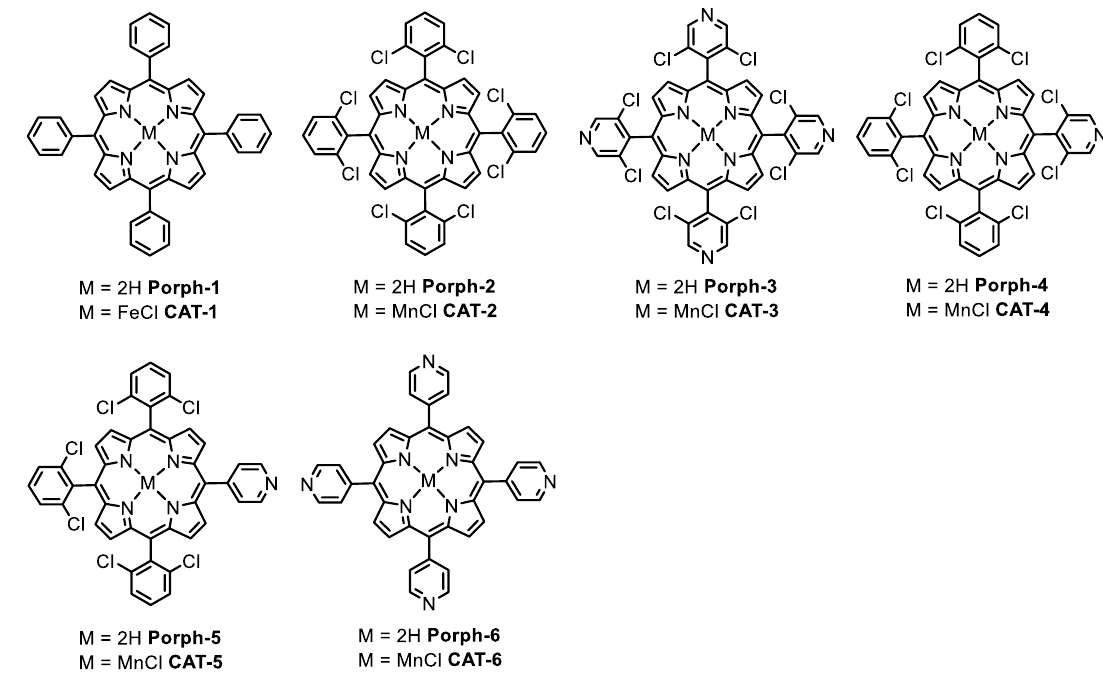
Figure 1. The structures of Porph-1 , Porph-2 and the metal complexes CAT-1 , CAT-2 (first- and second-generation catalysts, respectively) and the structures of the porphyrin ligands and Mn(III) complexes used in the present work.